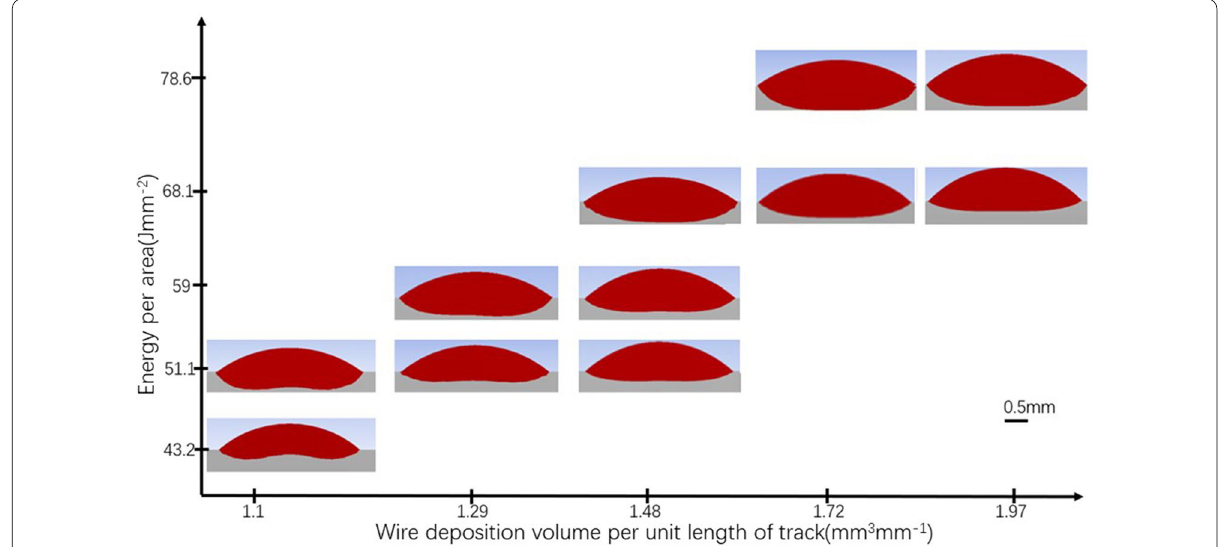
Figure 25 Clad cross-sections at H